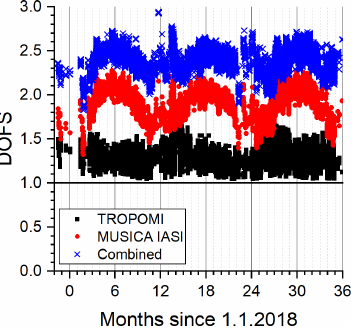
Figure 4. Time series of the degree of freedom for signal (DOFS; example for central Europe). Black squares: TROPOMI (please note that only the total-column data are made available); red dots: MUSICA IASI; blue crosses: combined